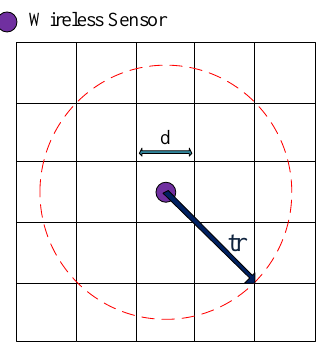
Figure 3. Transmitting range of wireless sensor and its relation to the length of the mesh grid.